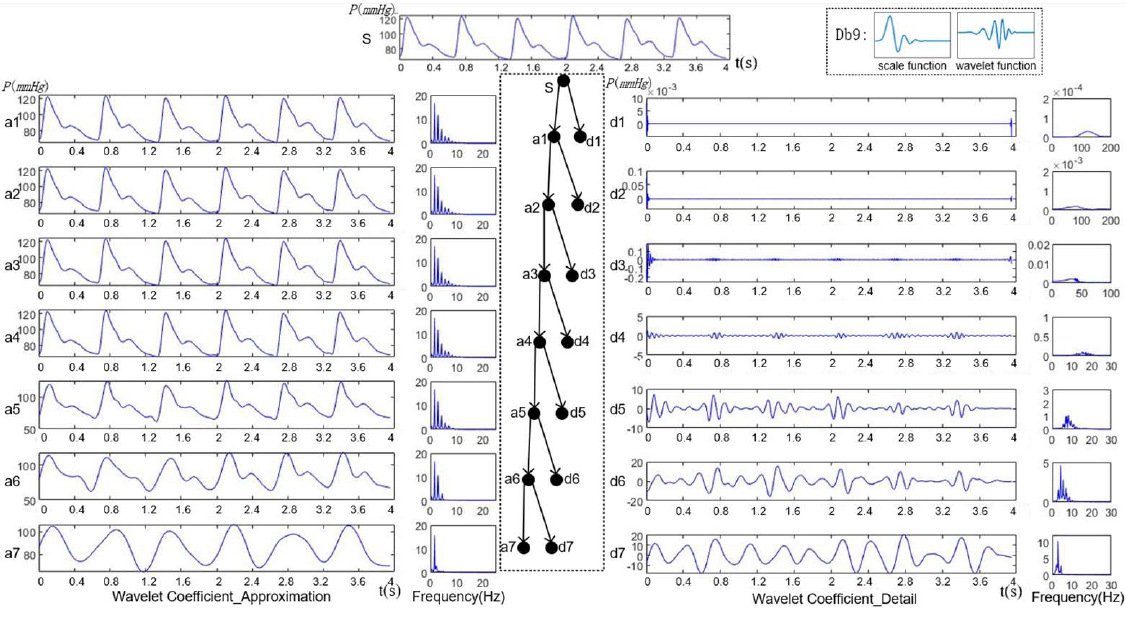
Figure 4. Wavelet decomposition of pulse waveform.